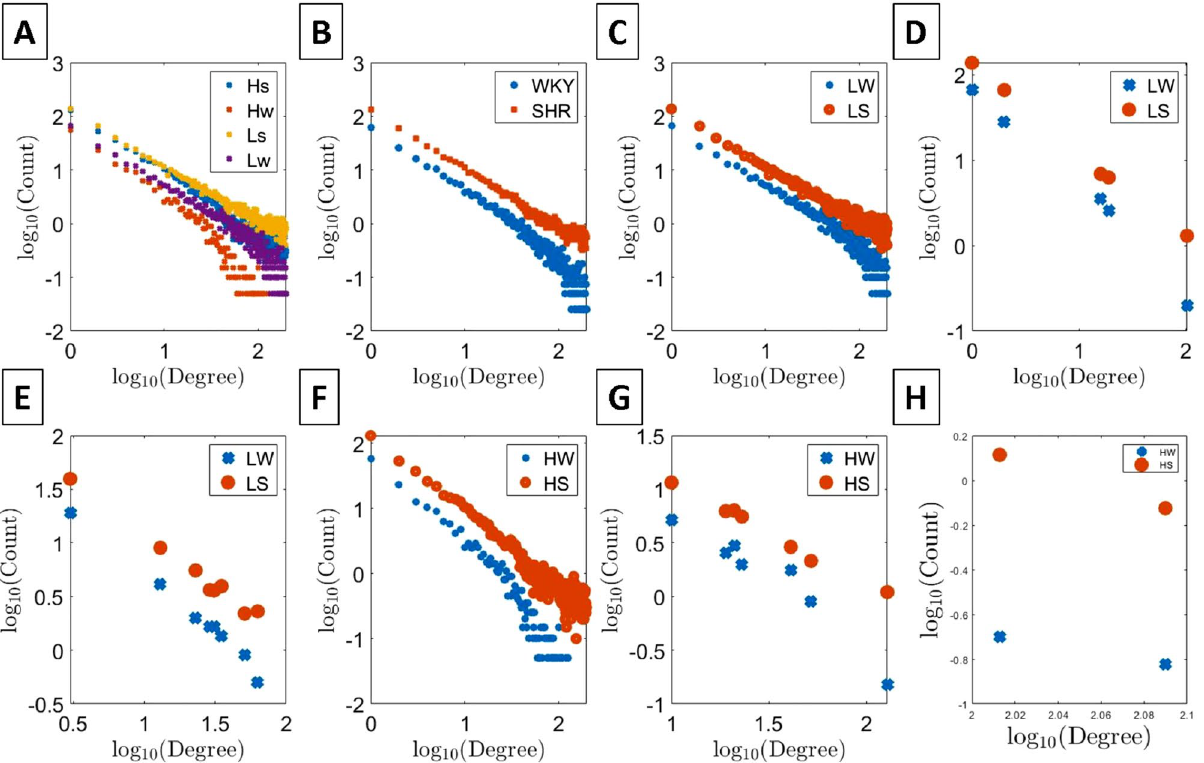
Figure 1. Power-law distribution consists of degree and its counted number. Each state, such as HS, HW, LS and LW, has 20 samples. Plots ( A ), ( B ), ( C ) and ( F ) are the distribution before chi2 algorithm. In ( B ), WKY and SHR are plotted without considering the anesthesia factor, and each distribution is deduced from 40 samples. In contrast, plots ( D ), ( E ), ( G ), and ( H ) are the distribution after chi2